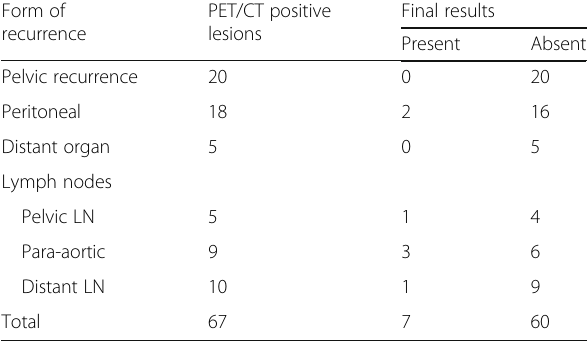
Table 1 Positive lesions at PET/CT compared to final results